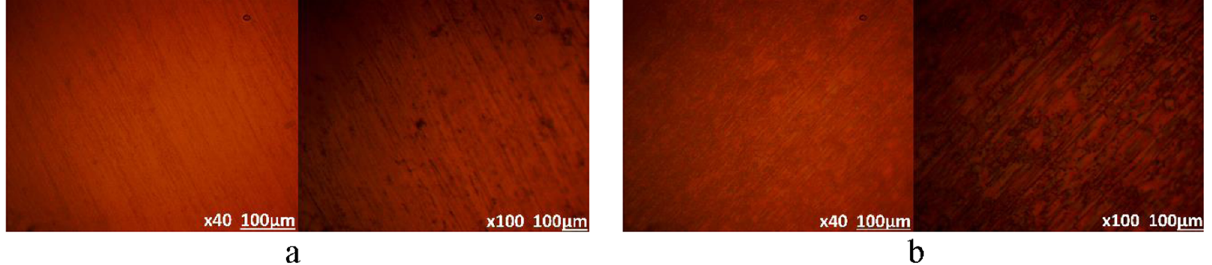
Figure 5: Optical images of B265TiN after corrosion test in ( a ) 2 M H 2 SO 4 + 10% NaCl and ( b ) 10 M H 2 SO 4 + 10% NaCl at